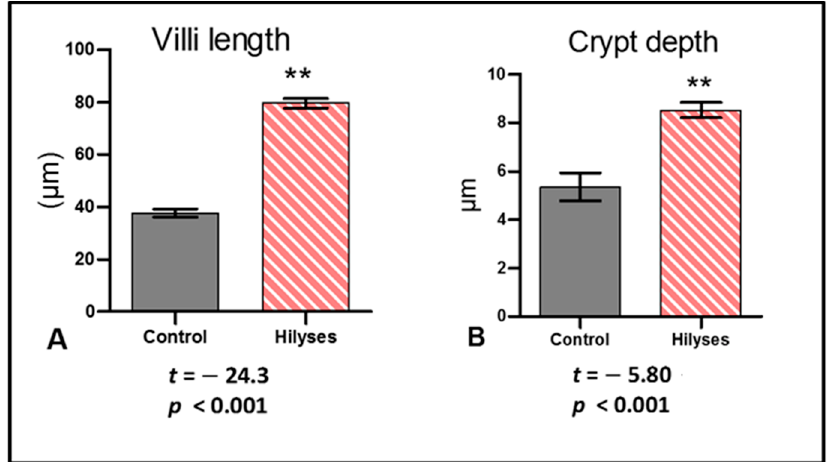
Figure 9. Morphometric analysis of the intestine. ( A ). Villi length; ( B ). Crypt depth. The results are expressed as the mean ± S.E. ( n = 10) and were analyzed statistically by independent samples t tests, ** statistically highly significant ( p < 0.01).